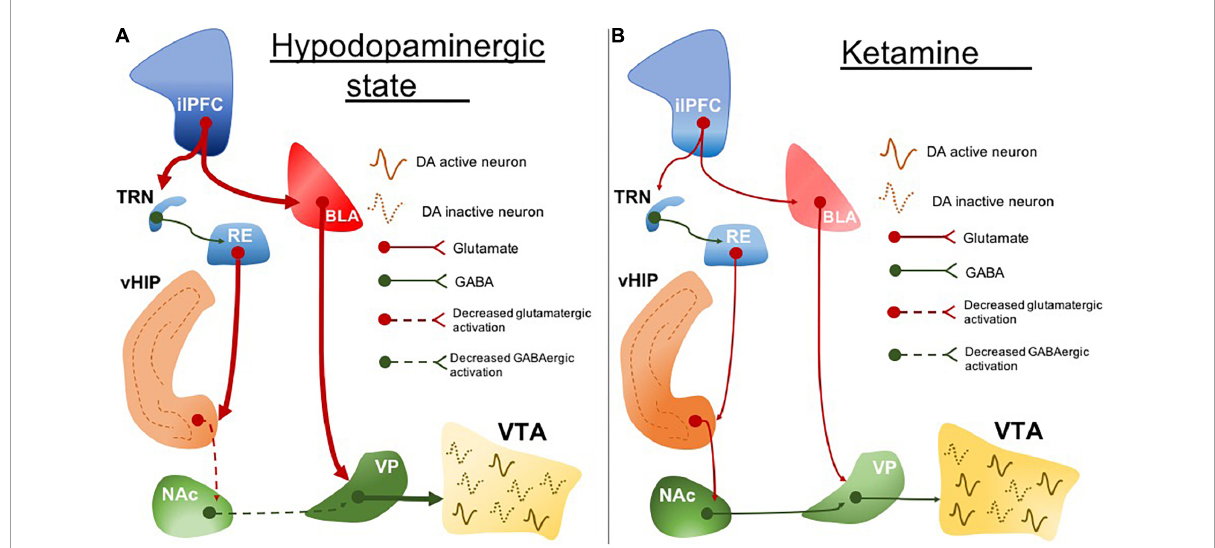
FIGURE1 The circuit disruption underlying the hypodopaminergic state is reversed by ketamine. (A) ilPFC hyperactivity increases BLA activity. BLA excitatory drive induces RE hyperexcitability which also may be a resultant of ilPFC inputs through TRN. RE projections disrupt the vHIP activity and its connectivity with NAc. Impairment of vHIP activity decreases the GABAergic tone from NAc to VP. VP excitability is resulting from a decreased NAc inhibitory drive and increased BLA excitatory drive. The increased inhibitory output of VP inhibits VTA and leads to a hypodopaminergic state. (B) Ketamine normalizes the hypodopaminergic state by downregulating the BLA activity in response to ilPFC activity restoration. The inputs coming from BLA and ilPFC are proposed to regulate the RE activity normalization. RE may represent one important neurobiological pathway underlying the reestablishment of the vHIP and NAc connectivity. Stabilization of NAc and BLA activity decreases the activity of VP inhibitory inputs to the VTA which ultimately restores dopaminergic activity. ilPFC, the infralimbic portion of the medial prefrontal cortex; BLA, basolateral amygdala; TRN, thalamic reticular nucleus; RE, reuniens thalamic nucleus; vHIP, ventral hippocampus; NAc, nucleus accumbens; VP, ventral pallidum; VTA, ventral tegmental area. Dotted lines, decreased pathway drive.